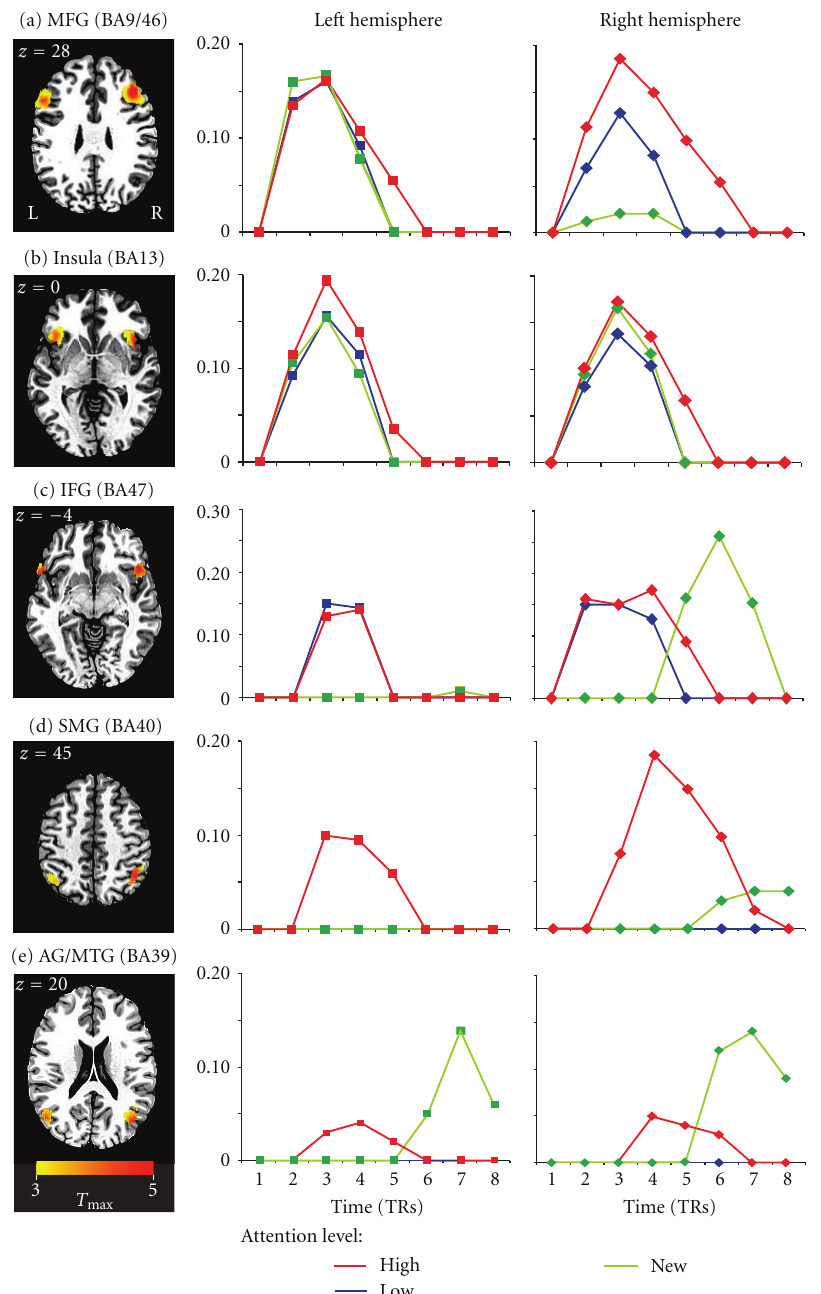
Figure 2: Brain regions showing significant group activation ( N = 14) associated with recognizing previously-encoded words ( High Attention , Low Attention ), and NEW words relative to the resting state. At left, axial slices show patterns of BOLD activation in each bilateral ROI overlaid onto canonical anatomical images ( z -depth in mm). (a) Middle Frontal Gyrus, MFG; (b) Anterior Insula; (c) Inferior Frontal Gyrus, IFG; (d) Supramarginal Gyrus, SMG; (e) Angular Gyrus/Middle Temporal Gyrus, AG/MTG. To the right of the activation maps in each row are plots of % BOLD signal change associated with memories of items in each word category, plotted over time (8 TRs). Each value represents peak activity extracted from each ROI at each time point, then averaged over the entire group. Only activity peaks that survived correction for multiple comparisons are shown. No standard errors were above 0.01%, therefore error bars were omitted for clarity.